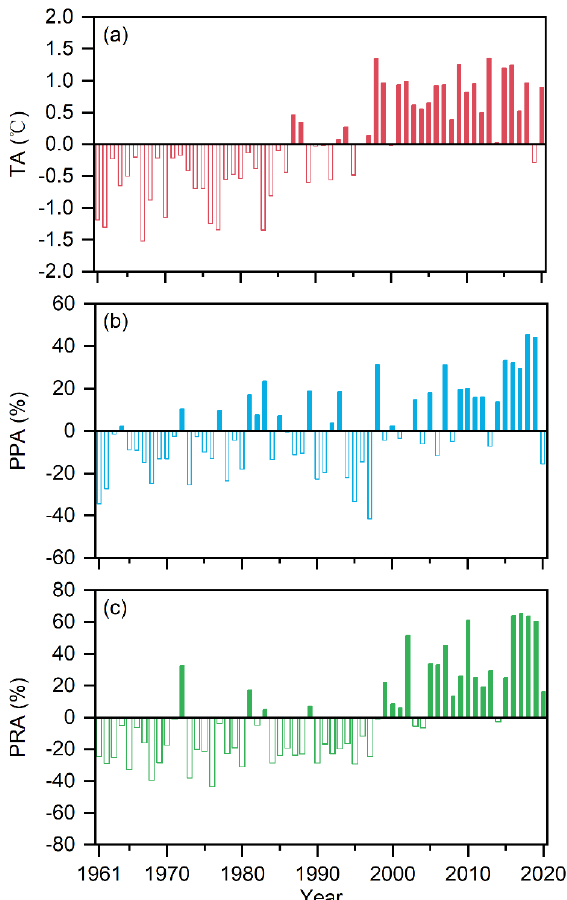
Figure 3. Interannual variation of annual mean temperature, annual precipitation and annual runoff in the USR from 1961 to 2020. ( a ) Temperature anomaly; ( b ) Percentage of precipitation anomaly; ( c ) Percentage of runoff anomaly.